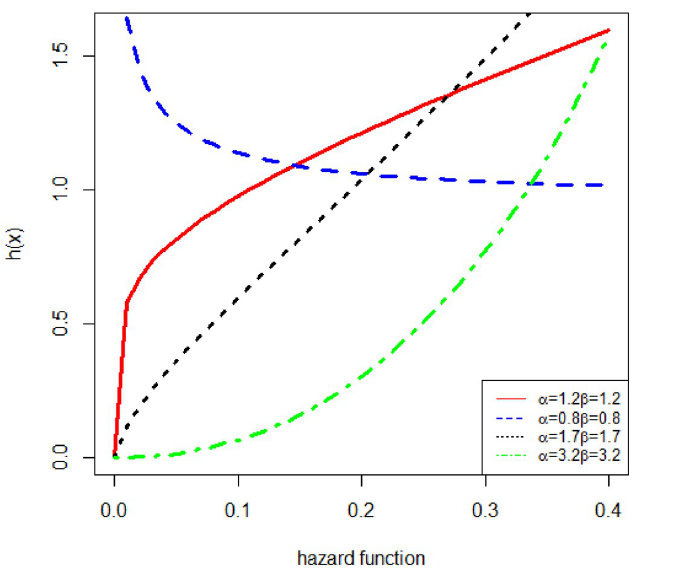
Fig 2. Plots of the hazard rate function of NFW.